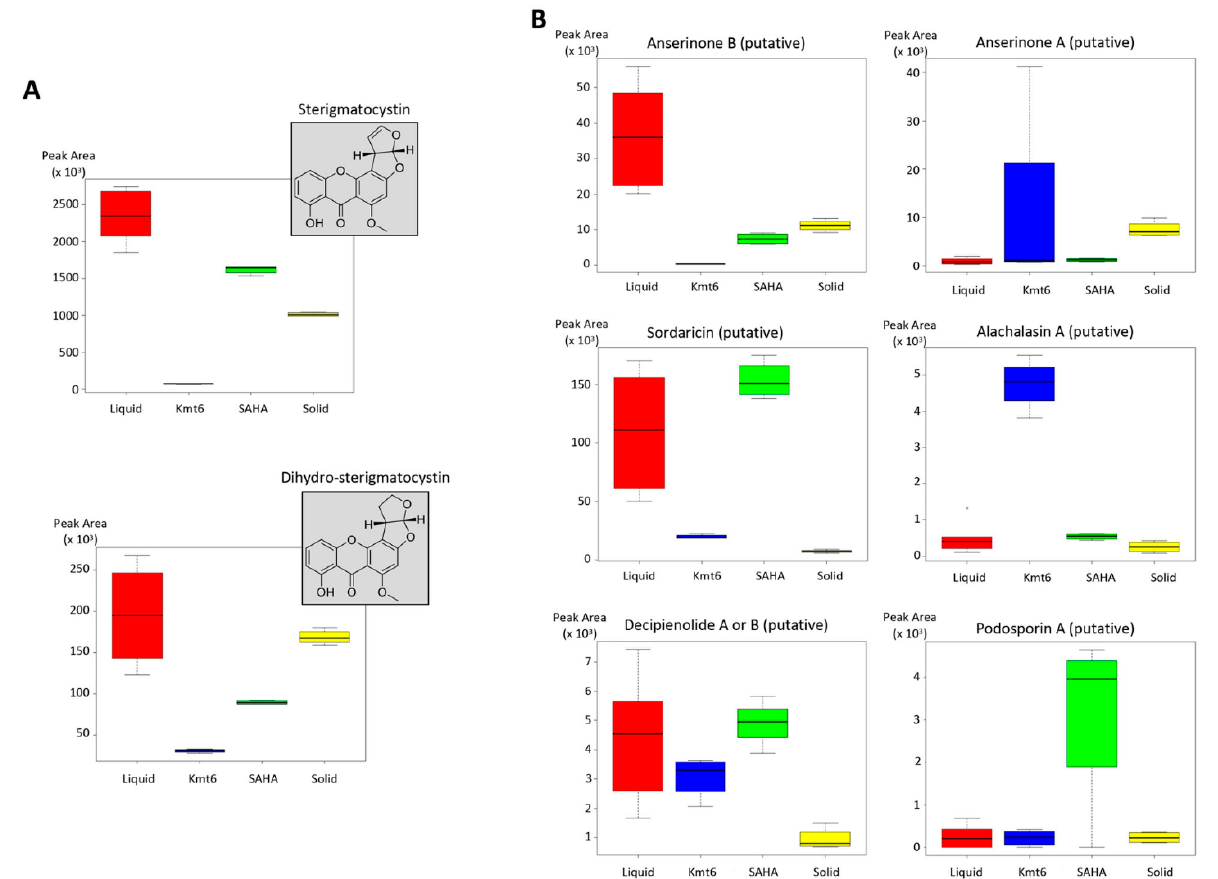
Figure 4. Boxplots representing the respective peak areas on the four different conditions for identified compounds sterigmatocystin (ST) ( t R = 10.21 min, m / z = 325.0705) and dihydro ‐ sterigmatocystin ( t R = 9.84 min, m / z = 327.0846) ( A ) and for putatively identified compounds already reported in Podospora genus ( B ): Anserinone B ( t R = 5.97 min, m / z = 211.1032), anserinone A ( t R = 6.81 min, m / z = 231.0633), sordaricin ( t R = 9.50 min, m / z = 333.2032), alachalasin A ( t R = 9.59 min, m / z = 390.2196), decipienolide A or B ( t R = 10.64 min, m / z = 379.2052), and podosporin A ( t R = 12.67 min, m / z = 441.2586). Peak areas were obtained via integration of the corresponding peak on extracted ion chromatograms from UPLC data. “Liquid”: M2 liquid medium inoculated with WT; “Solid”: M2 solid medium inoculated with WT; “SAHA”: M2 liquid medium supplemented with 100 μ M SAHA and inoculated with WT; “Kmt6”: M2 liquid medium inoculated with the Kmt6 mutant strain. All the experiments were performed in quadruplicates, except for the condition “Liquid” for which 8 replicates were performed.